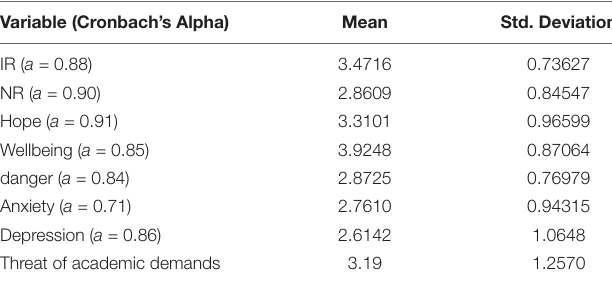
TABLE 2 | Means and standard deviations of the investigated